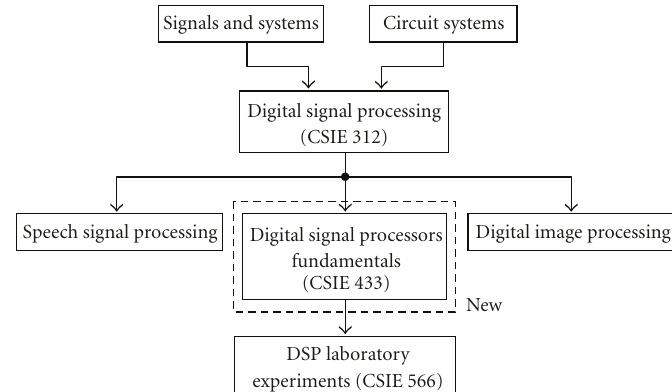
Figure 1: Flow chart of DSP-related courses [1].